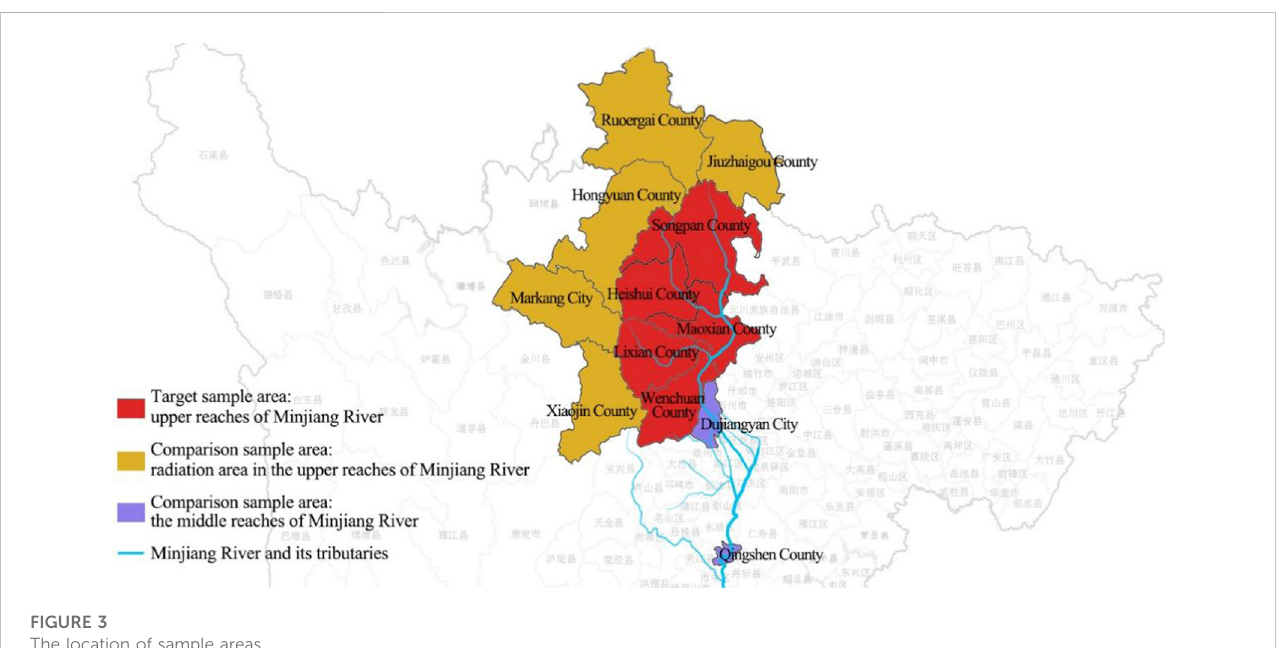
FIGURE 3 The location of sample